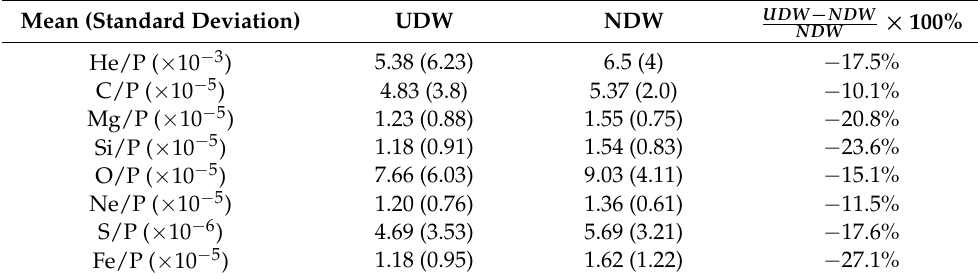
Table 1. Averages, standard deviations, and changing rates of the He/P, C/P, Mg/P, Si/P, O/P, Ne/P, S/P and Fe/P of the UDW and NDW measurements from ACE/SWICS during 1998–2011.